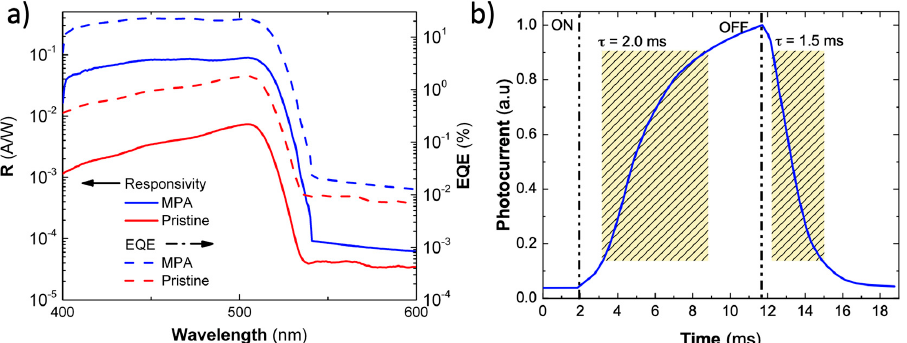
e ffi ciency (EQE) is represented by discontinued lines. ( b ) One response cycle of the MPA